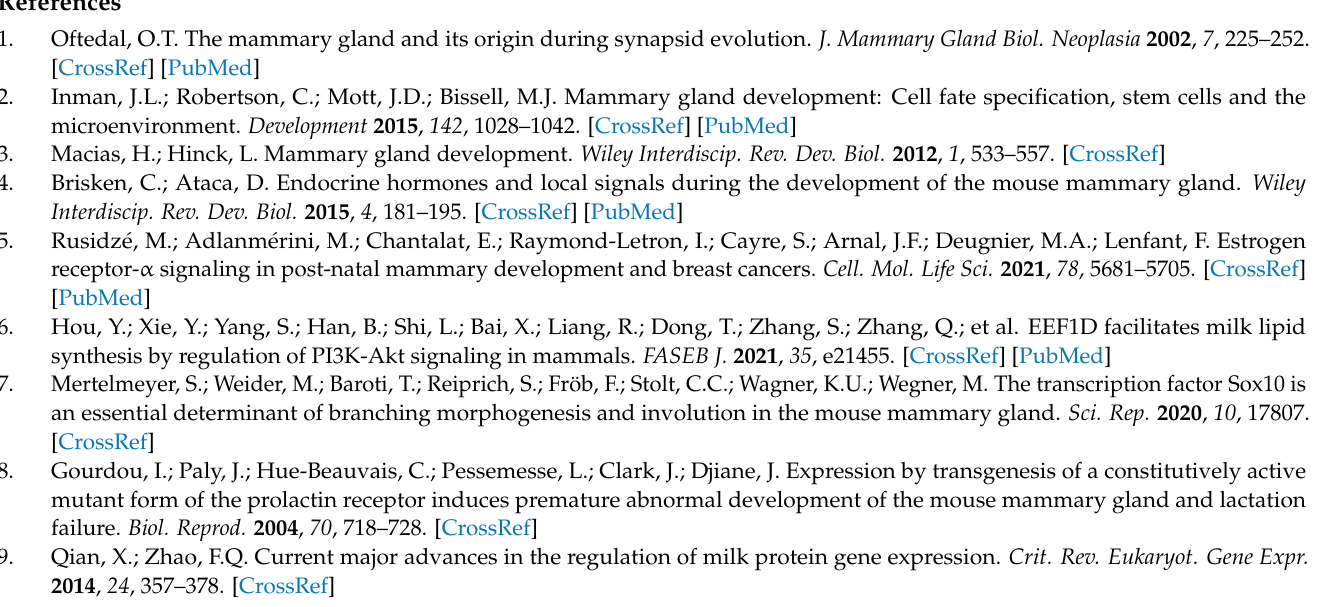
Table S1: Primers used in the present study; Supplementary Table S2: The proportion of reads mapped to the reference genome; Supplementary Table S3: TPM of miRNAs from murine mammary glands at five distinct stages; Supplementary Table S4: Target gene predictions for 12 miRNA clusters; Supplementary Table S5: GO enrichment analysis of cluster 1 miRNAs’ target genes; Supplementary Table S6: KEGG pathway analysis of cluster 1 miRNAs’ target